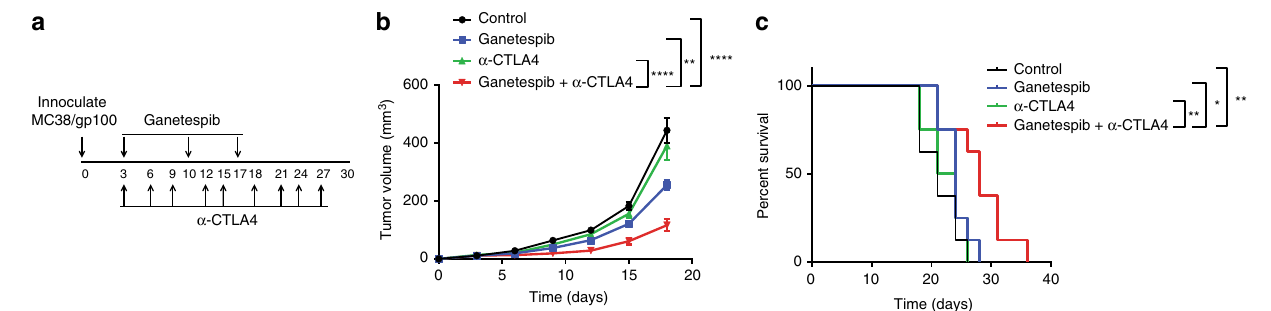
Fig. 3 HSP90 inhibition potentiates responses to immune checkpoint blockade in vivo. a Treatment schedule: Treatment with ganetespib and anti-CTLA begun at the same time. Ganetespib was administered at 100 mg/kg per mouse once a week and anti-CTLA4 at 100 µ g/mouse every 3 days. n = 8 mice. b Tumor volumes across treatment groups over time. c Survival of animals depicted by Kaplan – Meier curves. n = 8 mice. Vehicle = Solvent+Isotype antibody control. Mice were sacri fi ced when moribund or when tumor volume reached 1000 mm 3 or tumors developed ulceration > 3mm in diameter. The data represented as mean ± s.e.m. * P < 0.05; ** P < 0.01; *** P < 0.001; **** P < 0.0001 by two way ANOVA. Data are a representation of at least